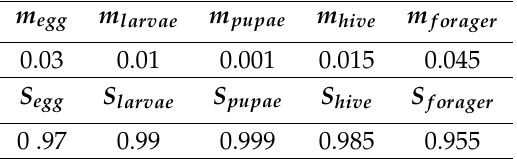
Table 3. Daily mortality ( m ) and survival ( S = 1 − m )